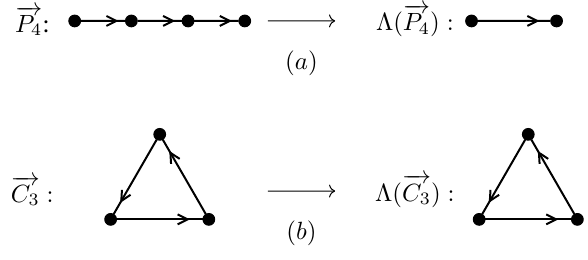
Figure 28: The operation of forming the path